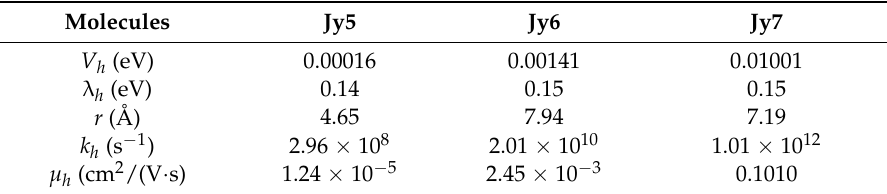
Table 6. The key parameters related to hole mobility of the three experimental molecules Jy5–Jy7: V